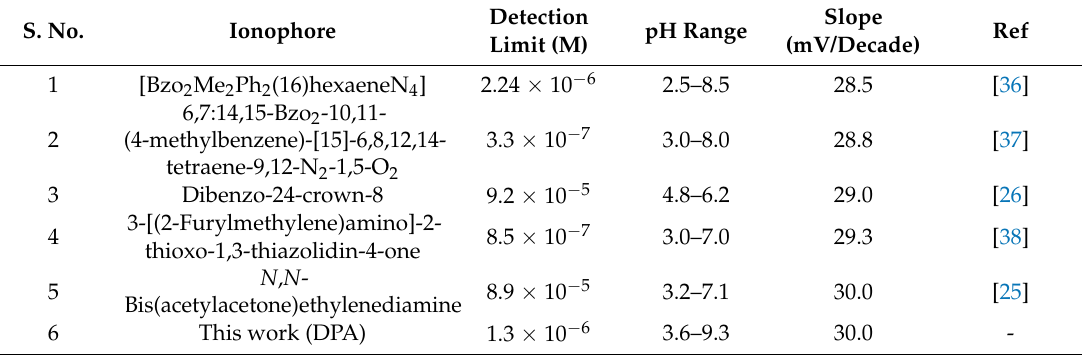
Table 6. Comparison of proposed TPA-based Ni 2+ selective electrode with the reported electrodes. S.